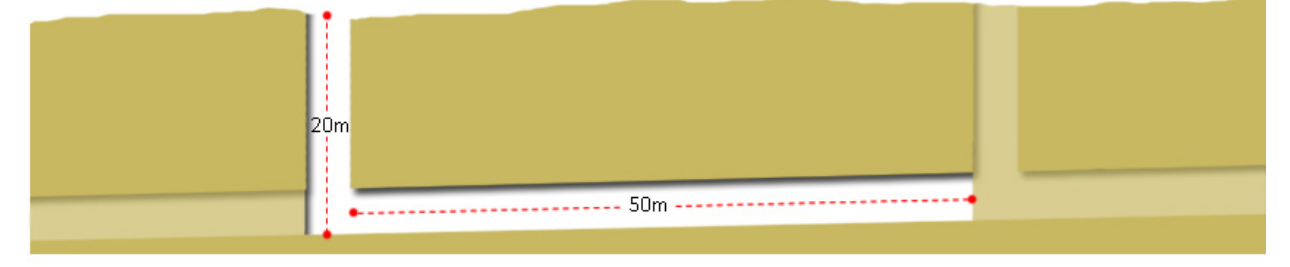
14 Figure 19. The continuous worker. 5.5. Simulation of the Construction Estimating the average dimensions by the analytical profile of the Hadrianic aque- duct, we simulated it with a hypothetical tunnel 20 km long with a mean cross-section 0.5